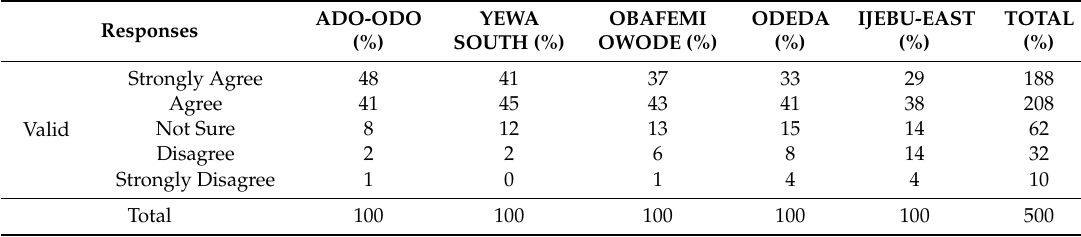
Figure 7. Is SWM a costly endeavour to the community?